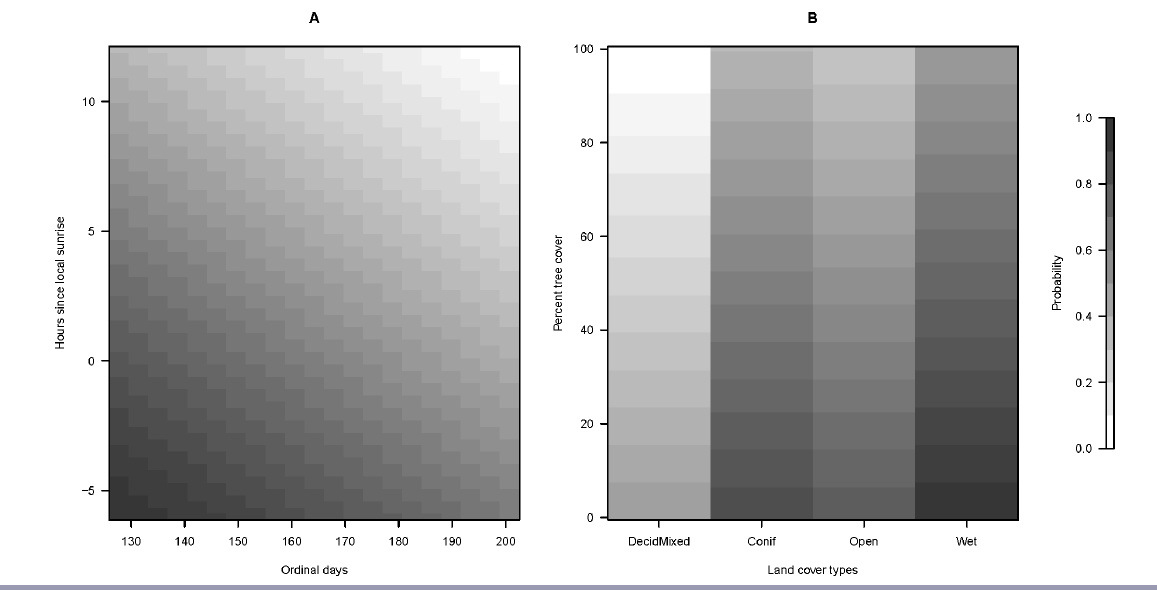
Fig. 2 . Probability of availability (range: 0.43-0.99) as a function of survey date (ordinal day: day of year) and survey time (hours since local sunrise) and given point count duration of 3 minutes (A); and probability of perceptibility (range: 0.69-0.99) as a function of habitat type and tree cover (B) and given 100-m point count radius. Dark shades in legend indicate higher